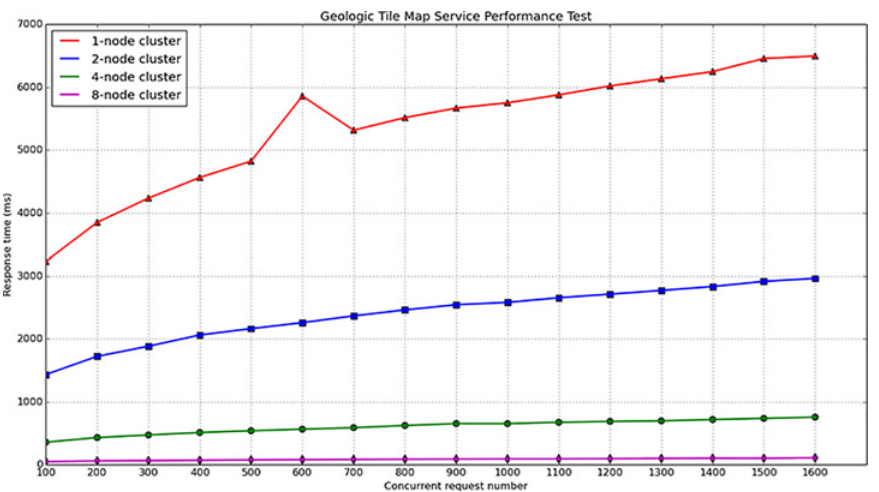
Fig 18. The geologic tile map service performance test